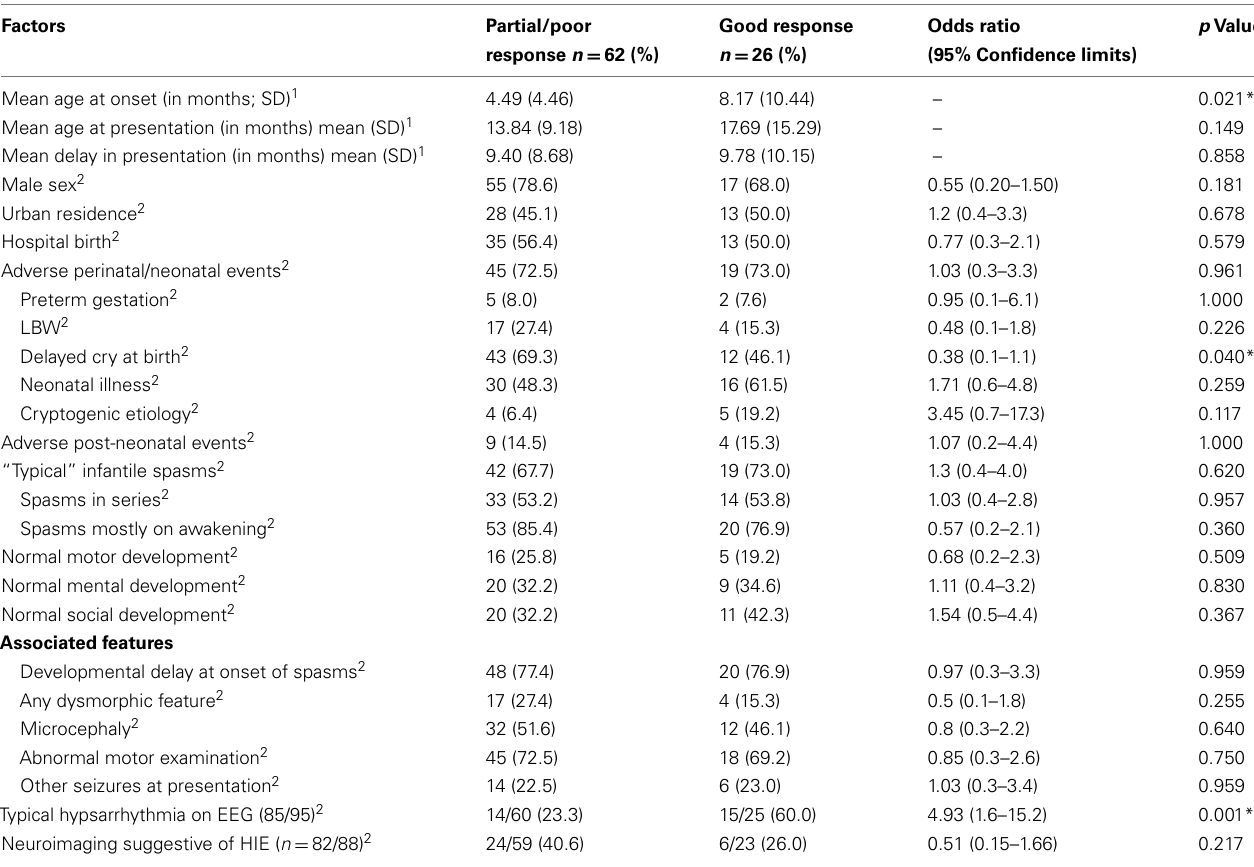
Table 2 | Comparison of patients who showed a sustained response to valproate with those who had partial/poor response or